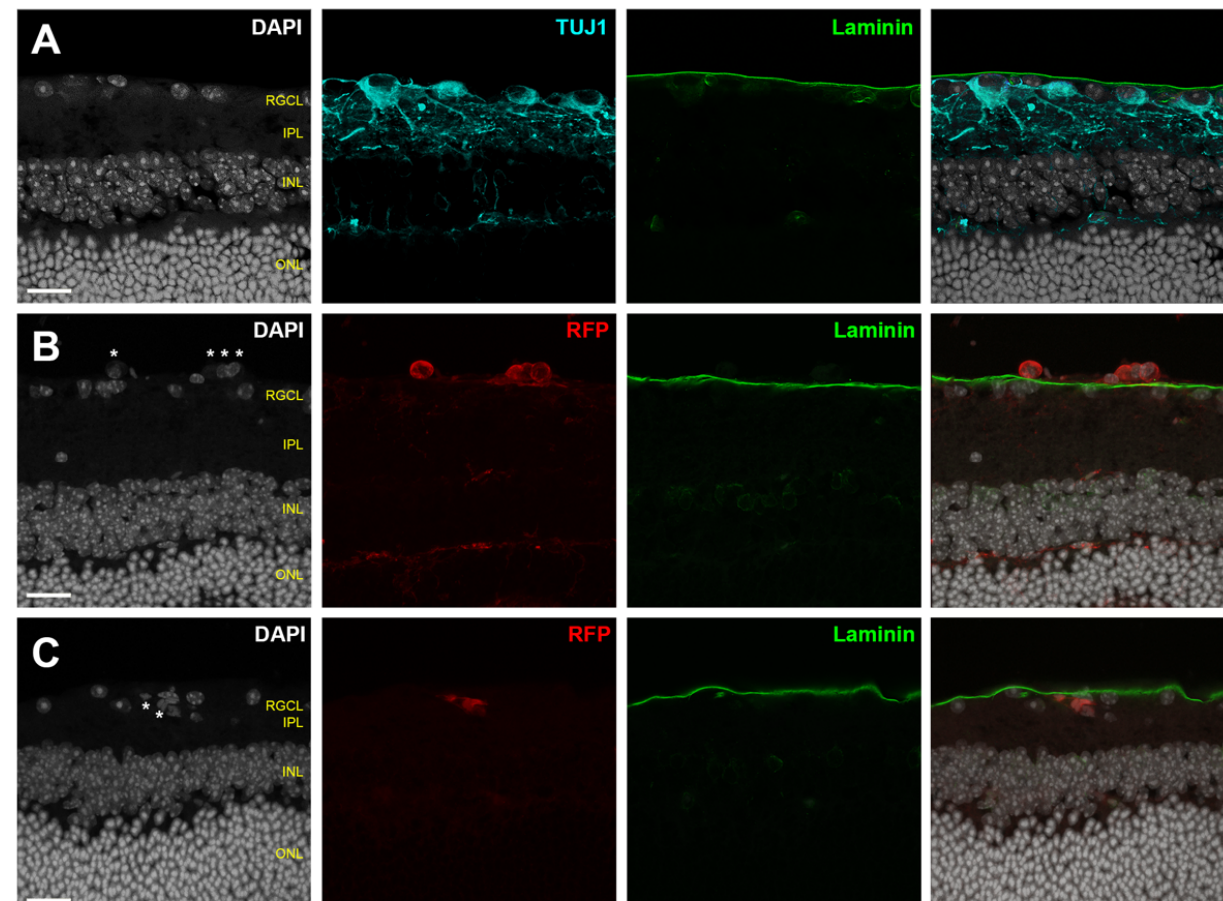
Figure 3. Adult mouse retinal cross-sections showing laminin expression (green) in the intact ILM in relation to endogenous TUJ1 + RGCs (row A , cyan) and intravitreally transplanted RFP + human stem cell derived RGCs ( B , C , red). DAPI staining (white) demonstrates close proximity of transplanted RGC (asterisks) to the endogenous RGCs. Endogenous RGCs reside within the retinal parenchyma bounded by the ILM ( A ). Transplanted RGCs are typically excluded from the host RGCL ( B ), but rarely may migrate across an intact ILM and localize within the host retinal parenchyma ( C ). Scalebars: 20 μm. RGCL—retinal ganglion cell layer; IPL—inner plexiform layer; INL—inner nuclear layer; ONL—outer nuclear layer.